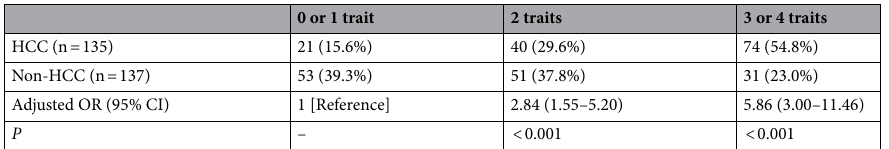
Table 4. Association between the number of metabolic traits and MAFLD-HCC on multivariate logistic regression analysis. HCC, hepatocellular carcinoma. *Adjusted for CRP > 2 mg/L and Waist circumference.